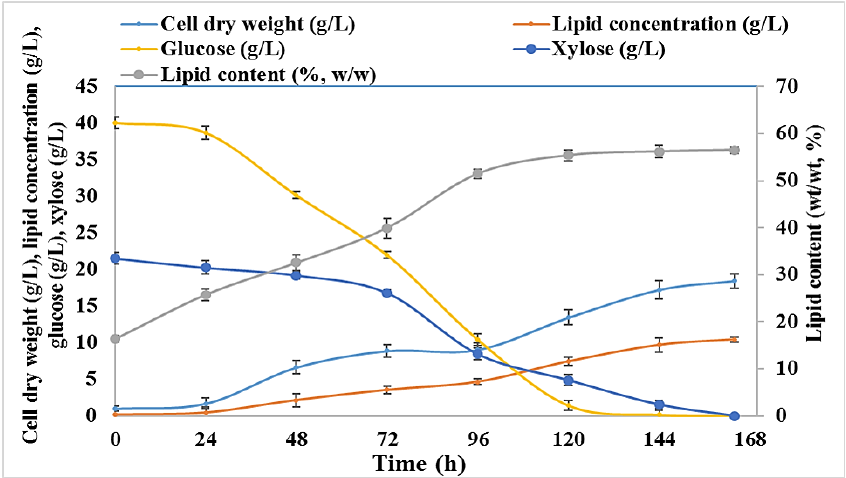
Figure 4. Time course experiments for cell dry weight (g/L), total lipid concentration (g/L), lipid content (% w / w ) and residual glucose and xylose in R. toruloides grown for 168 h on BSG hydrolysate with C/N